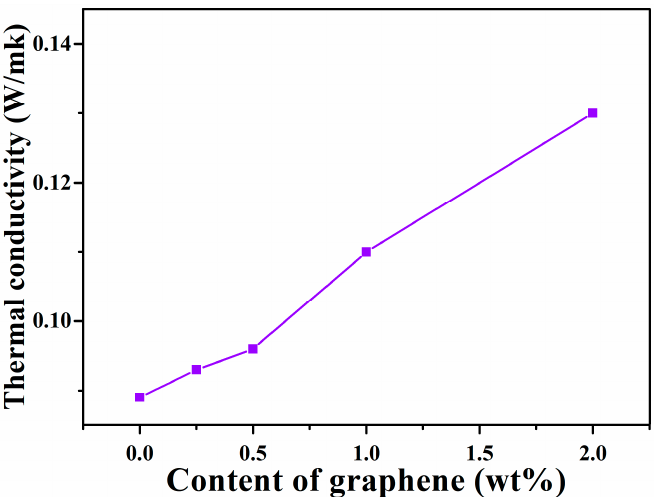
Figure 6. Thermal conductivity of SIS and graphene/SIS composites.